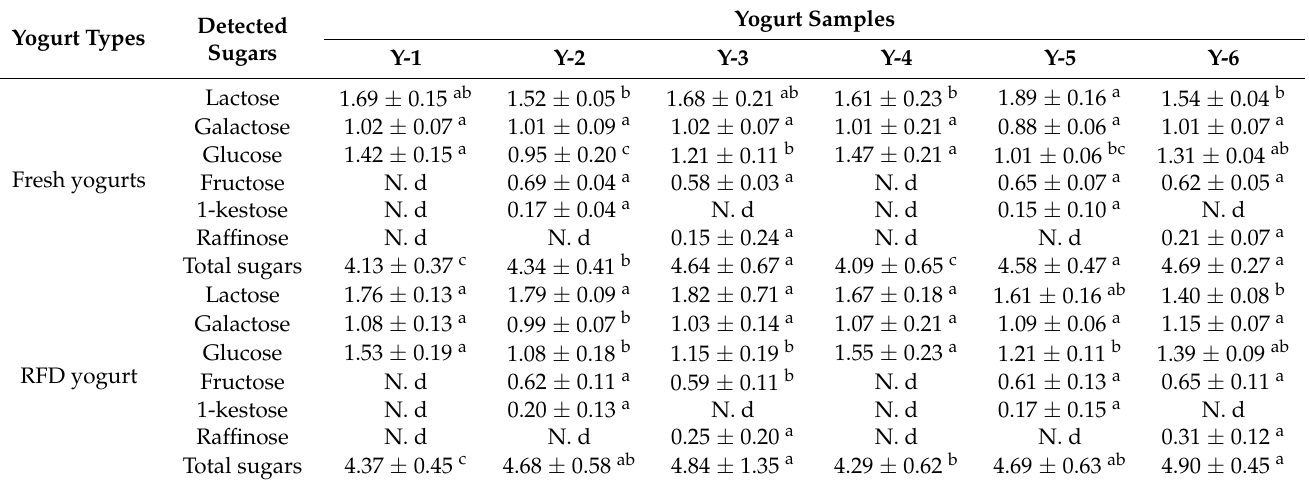
Table 4. Sugar contents (g/100 g) in fresh and RFD